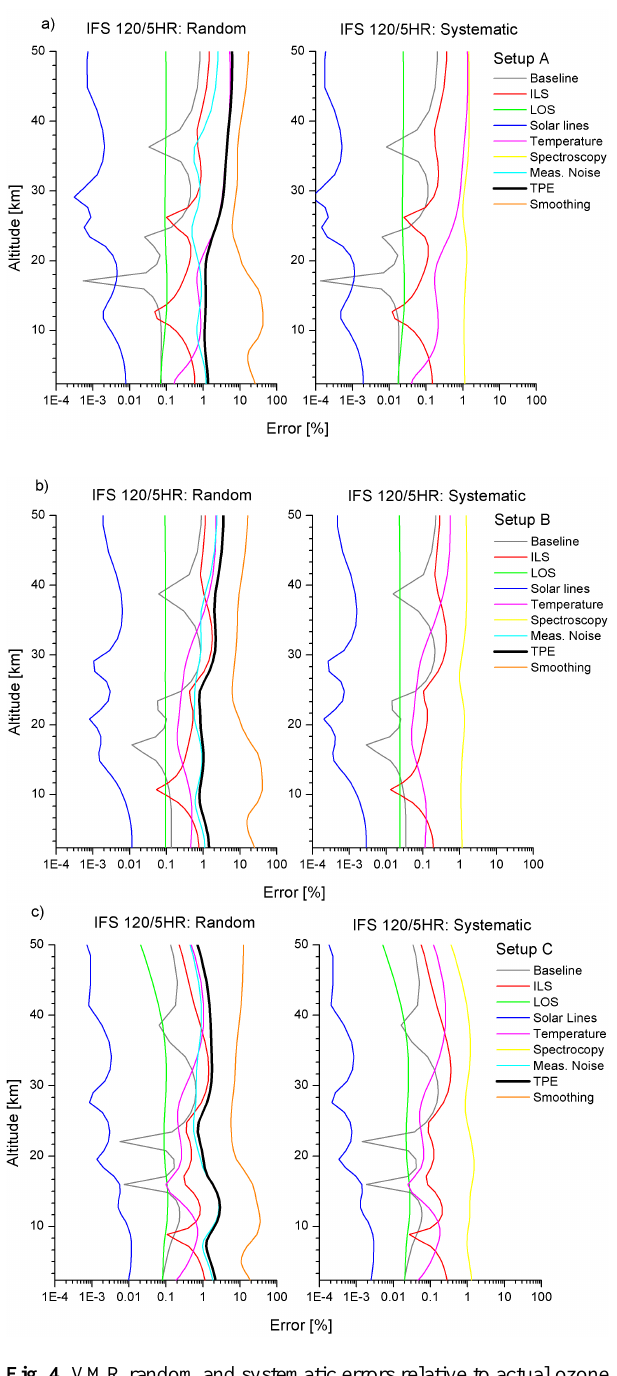
Fig. 4. VMR random and systematic errors relative to actual ozone VMR profiles [%] for the Iza˜na IFS 120/5HR for the setups A (a) , B (b) and C (c) . ILS means the joint error due to the modulation efficiency and phase error uncertainties and TPE (Total Parameter Error, black line) is the sum of all random errors except for smooth- ing